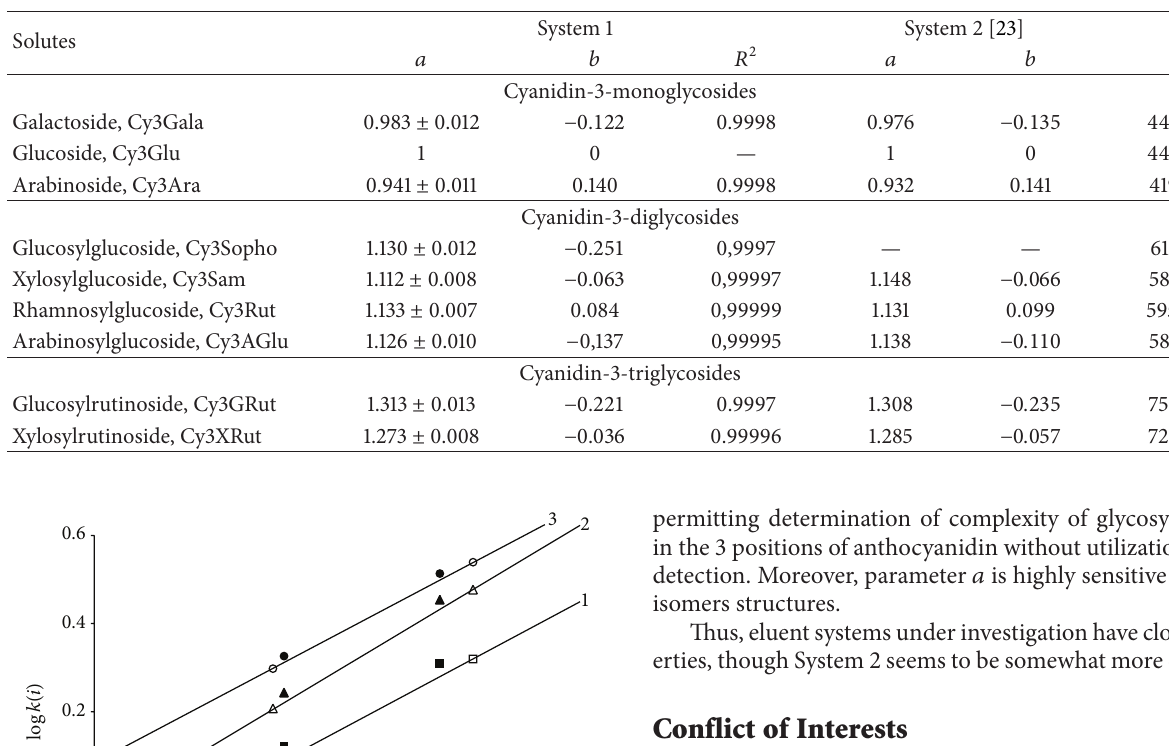
Table 2: Parameters of relative retention (3) of some cyanidin-3-glycosides.